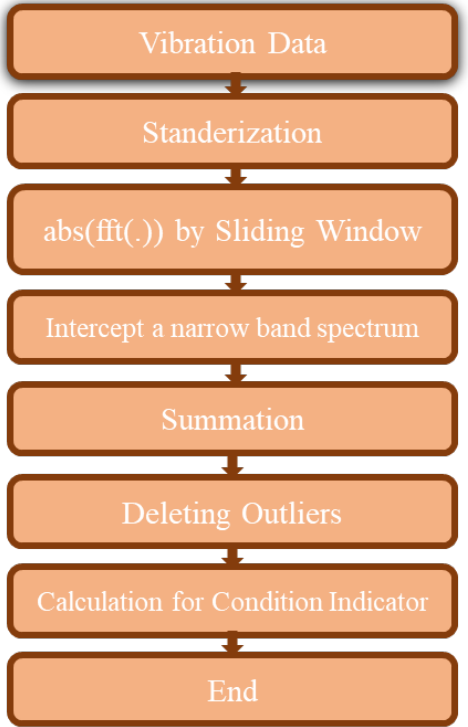
Figure 3. A flow chart showing the steps of the feature extraction procedure [5].